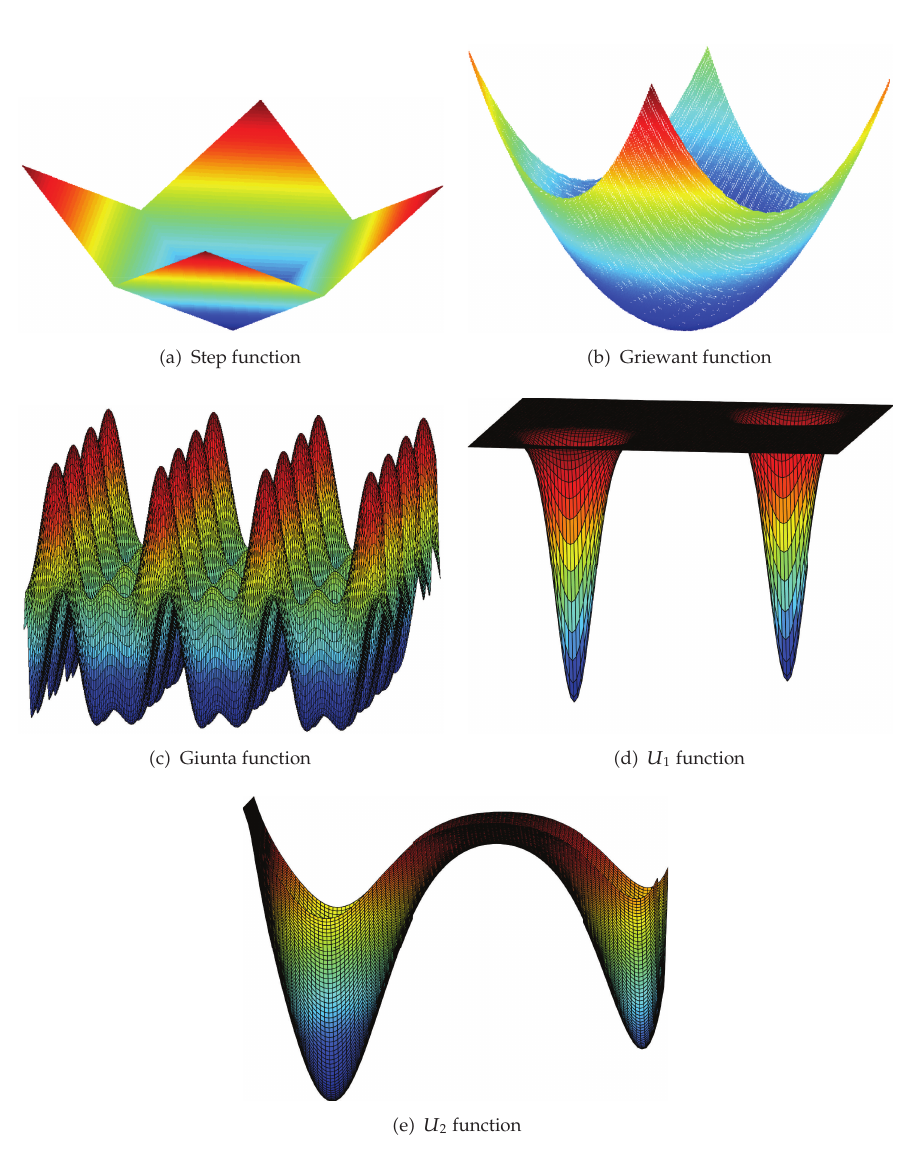
Figure 1: Graphs of the five objective